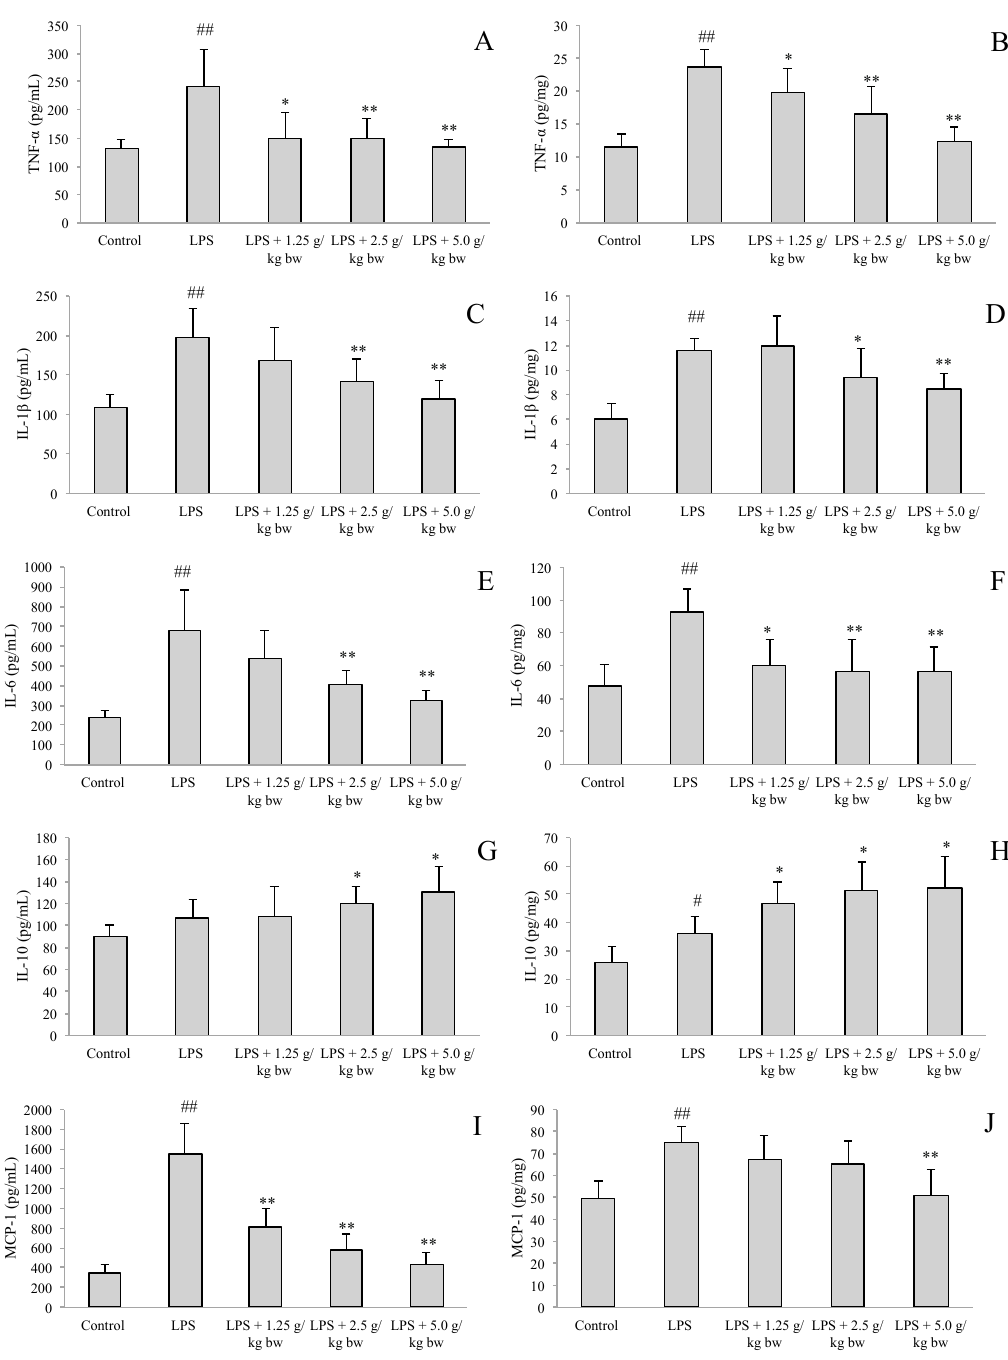
Figure 3. Effects of water extract of H. diffusa on the levels of TNF- α ( A , B ), IL-1 β ( C , D ), IL-6 ( E , F ), IL-10 ( G , H ), and MCP-1 ( I , J ) in serum and renal tissue of mice. Results are expressed as means ± SD ( n = 8). * p < 0.05, ** p < 0.01 compared with LPS group; # p < 0.05, ## p < 0.01 compared with control group.